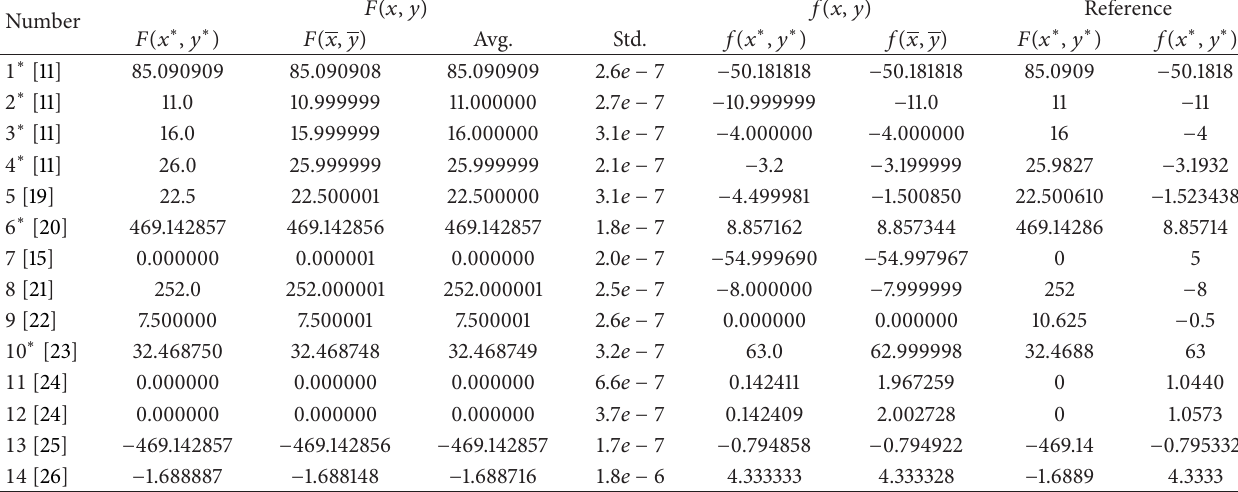
Table 1: The results found by EDA-NM and compared algorithms in the corresponding references.